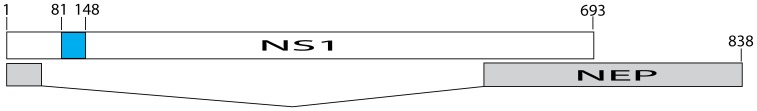
Diagram of the segment 8 (NS1/NEP) coding region.Numbering begins at the start of the NS1 open reading frame (ORF). White and shaded bars depict NS1 and NEP ORFs, respectively. Diagonal lines indicate the segment 8 intron and the blue box represents the 81–148 nt region.